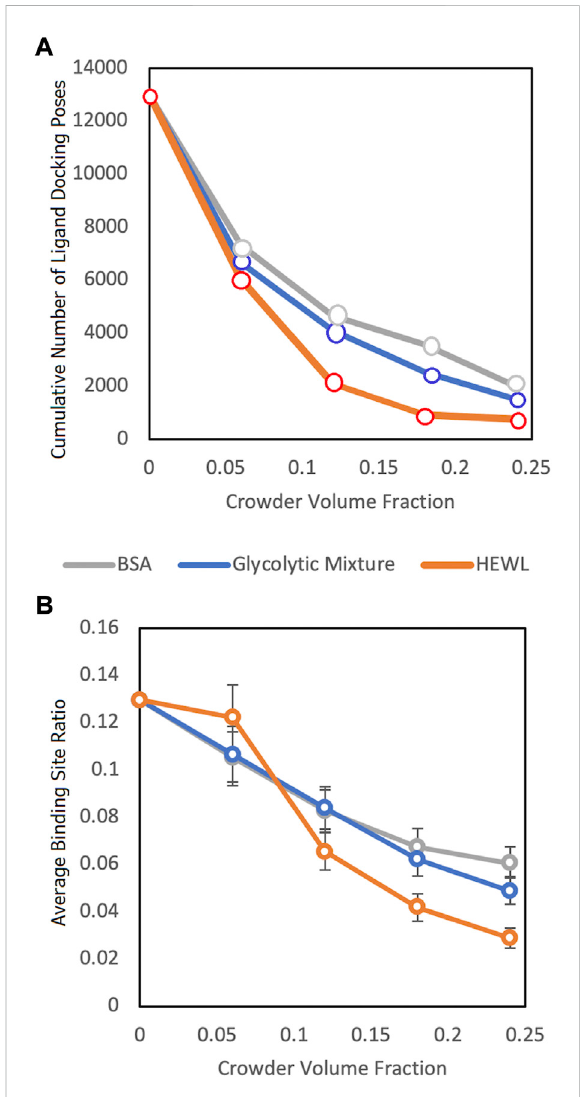
FIGURE 5 Funnel size vs. crowder volume fraction for three different crowder systems (see legend). (A) Cumulative number of the ligand poses in the receptor binding sites without clashes with the crowders for the entire protein-protein set and all 100 replicas. (B) The binding site ratio, η (i), (Eq. 1) averaged over all complexes in the entire dataset.